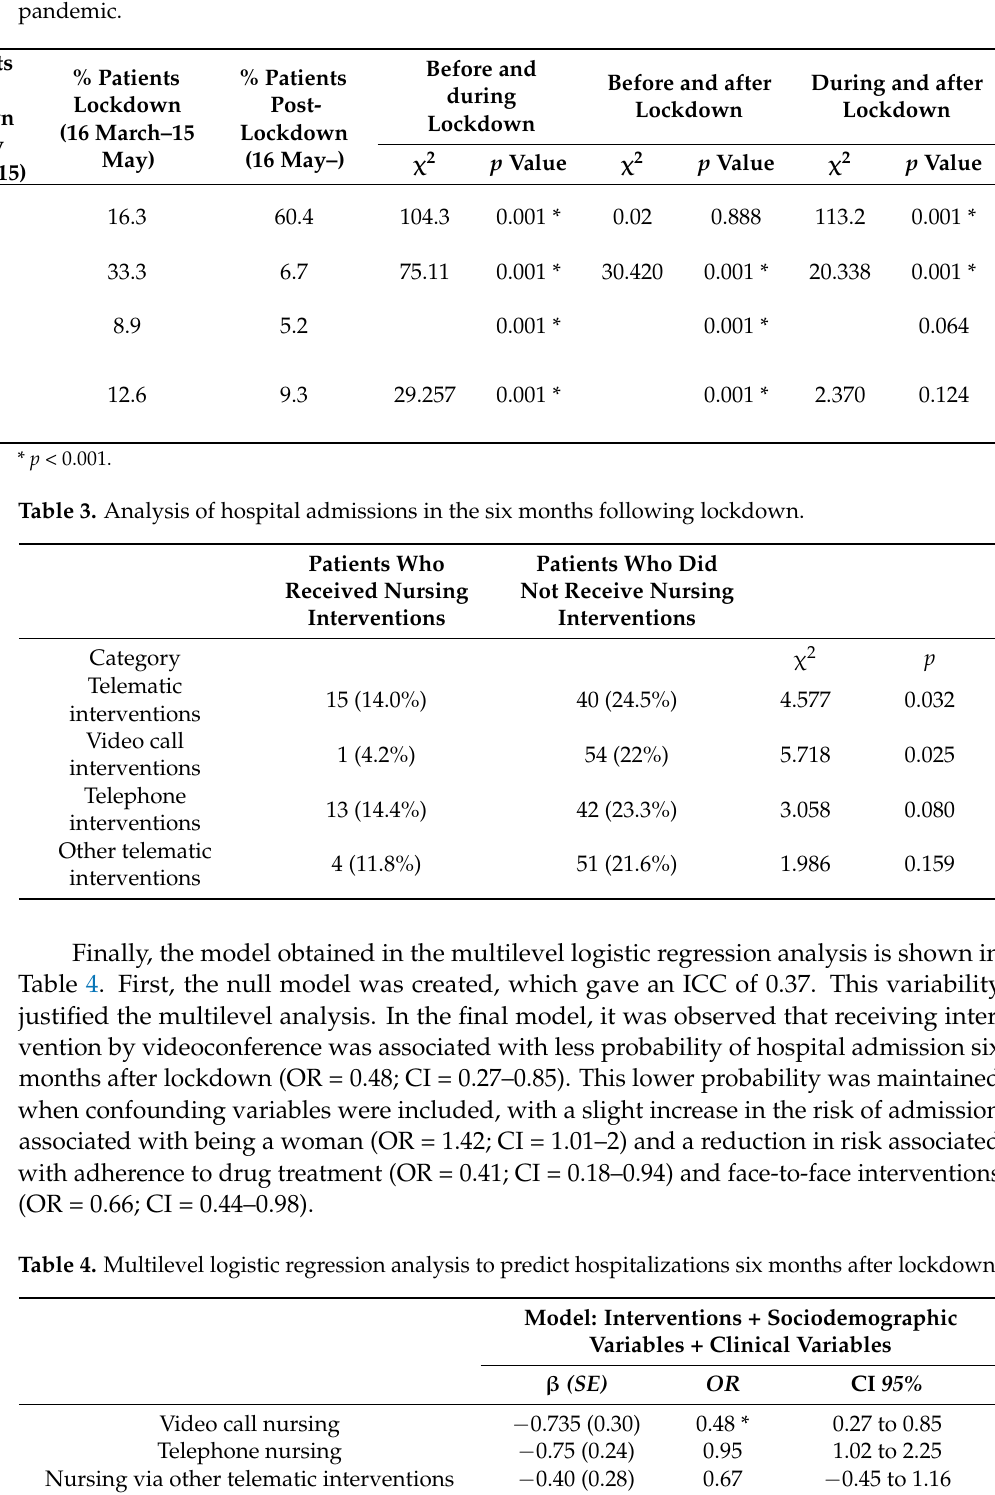
Table 2. Analysis of nursing interventions received pre-pandemic, during lockdown, and post- pandemic.